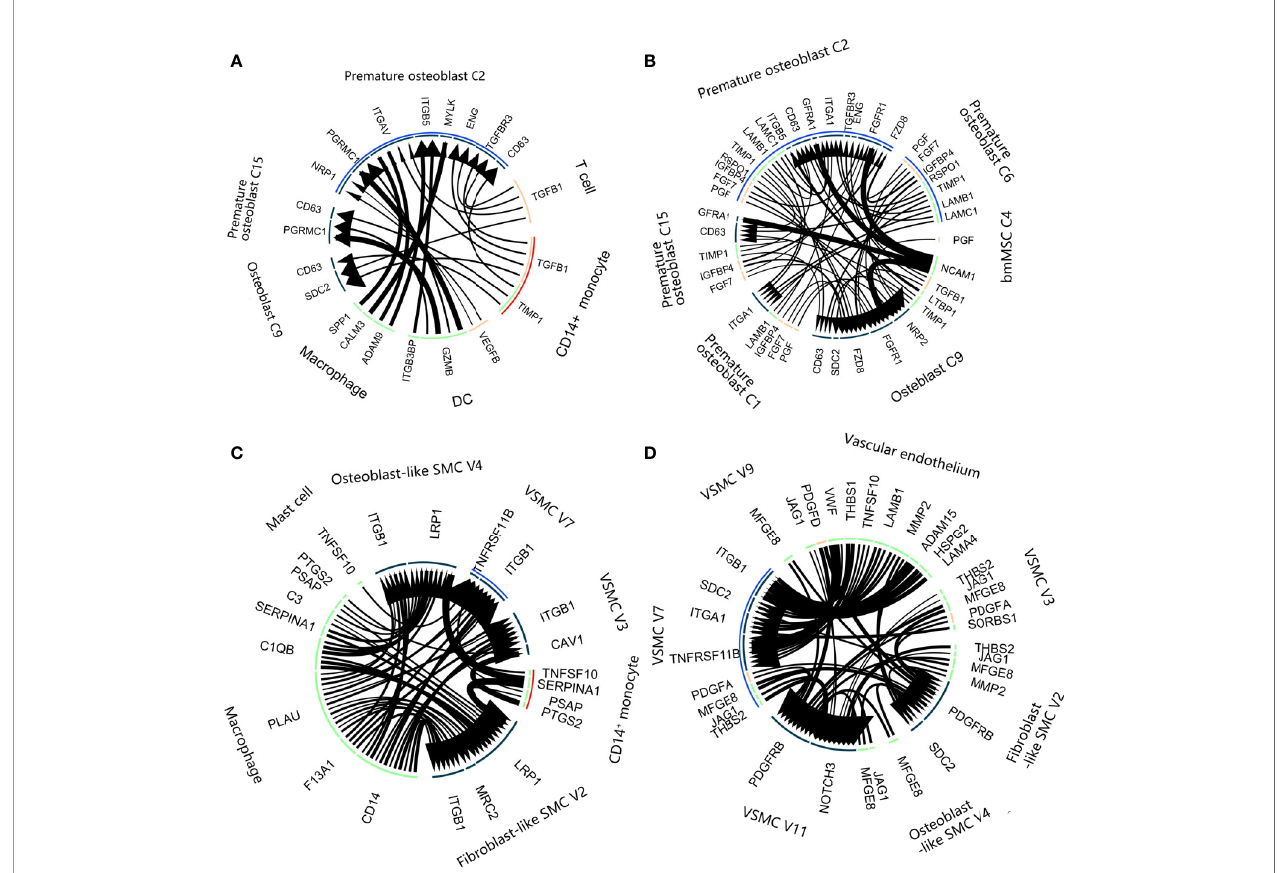
FIGURE 7 | Ligand – receptor interactions in calci fi cation paradox-related bone and vascular environments. (A, B). Ligand – receptor interaction plot in the bone environment with osteoporosis. (A) Interaction between the osteoblast lineage and other cell types in the environment. (B) Interaction among the osteoblast lineages. The arrow direction indicates the direction of the ligand – receptor interaction, in which the arrow is the receptor and the nock is the ligand. The thickness of the line indicates the relative expression levels from high to low. The blue arc covered intermediate states C2 and C6. The red arc covers the C14 + monocytes. (C, D). Ligand – receptor interaction plot in the vascular environment with atherosclerosis. (A) Interaction between the vascular SMC lineage and other cell types in the environment. (B) Interaction among the vascular SMC lineage. The arrow direction indicates the direction of the ligand – receptor interaction, in which the arrow is the receptor and the nock is the ligand. The thickness of the line indicates the relative expression levels from high to low. The blue arc covered the intermediate state V7. The red arc covers the C14 +